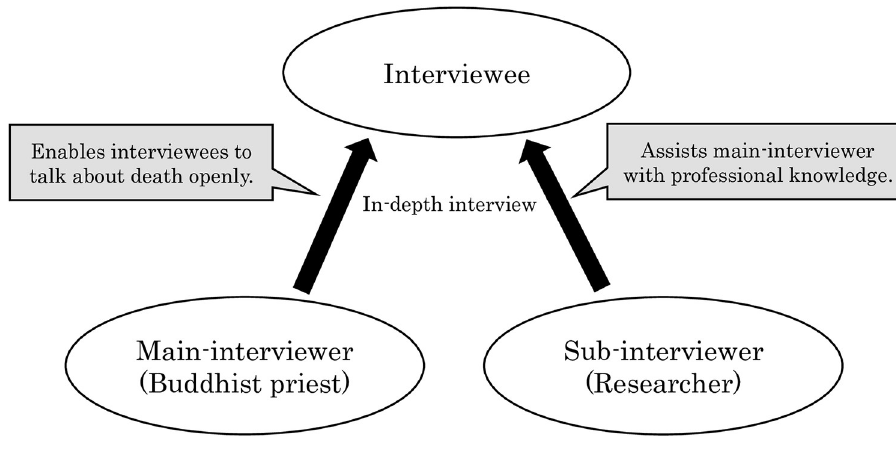
Fig 2. Interview